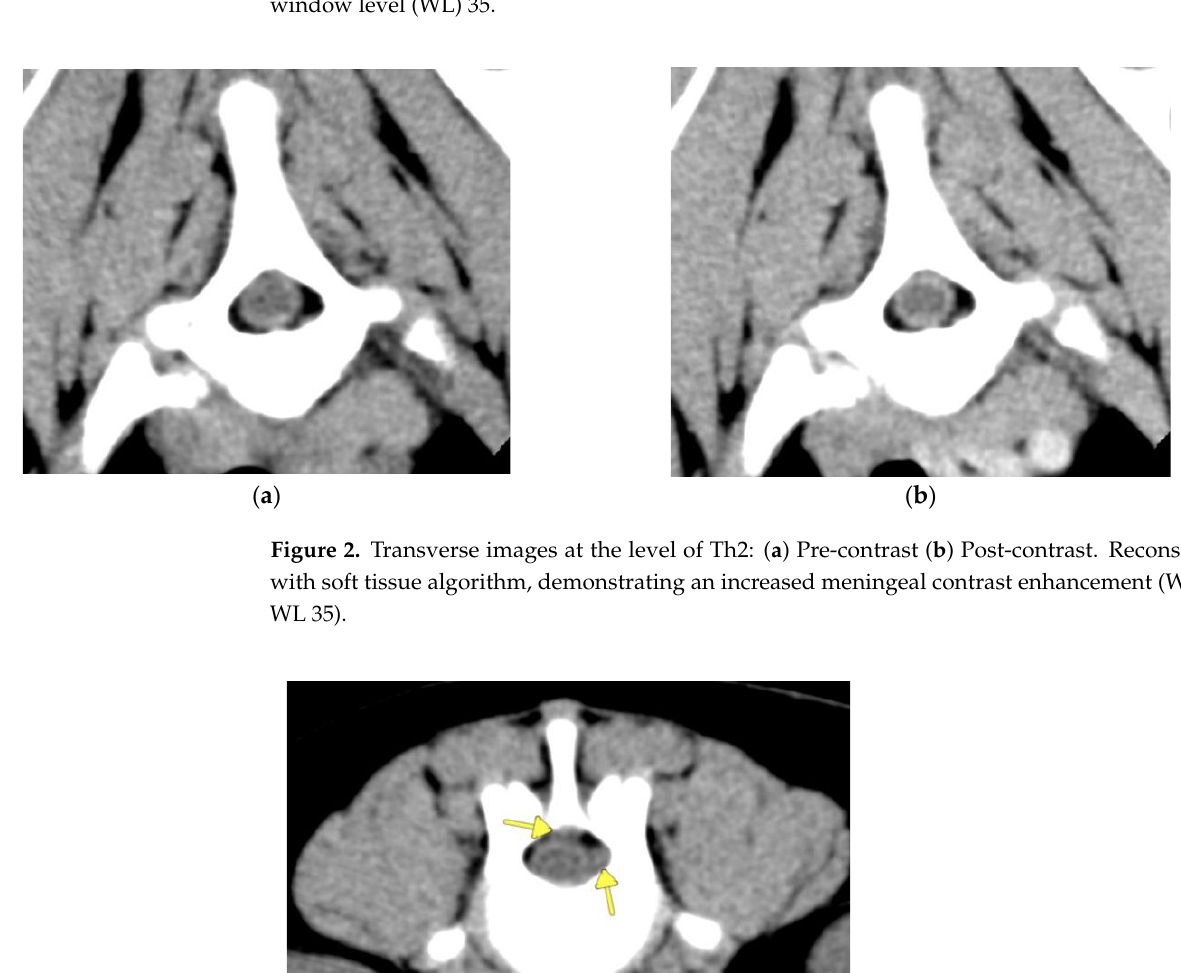
Figure 3. Transverse pre-contrast image at the level of L3, showing a small extradural mass lesion (arrows). Reconstructed with soft tissue algorithm, WW 150, WL 35.